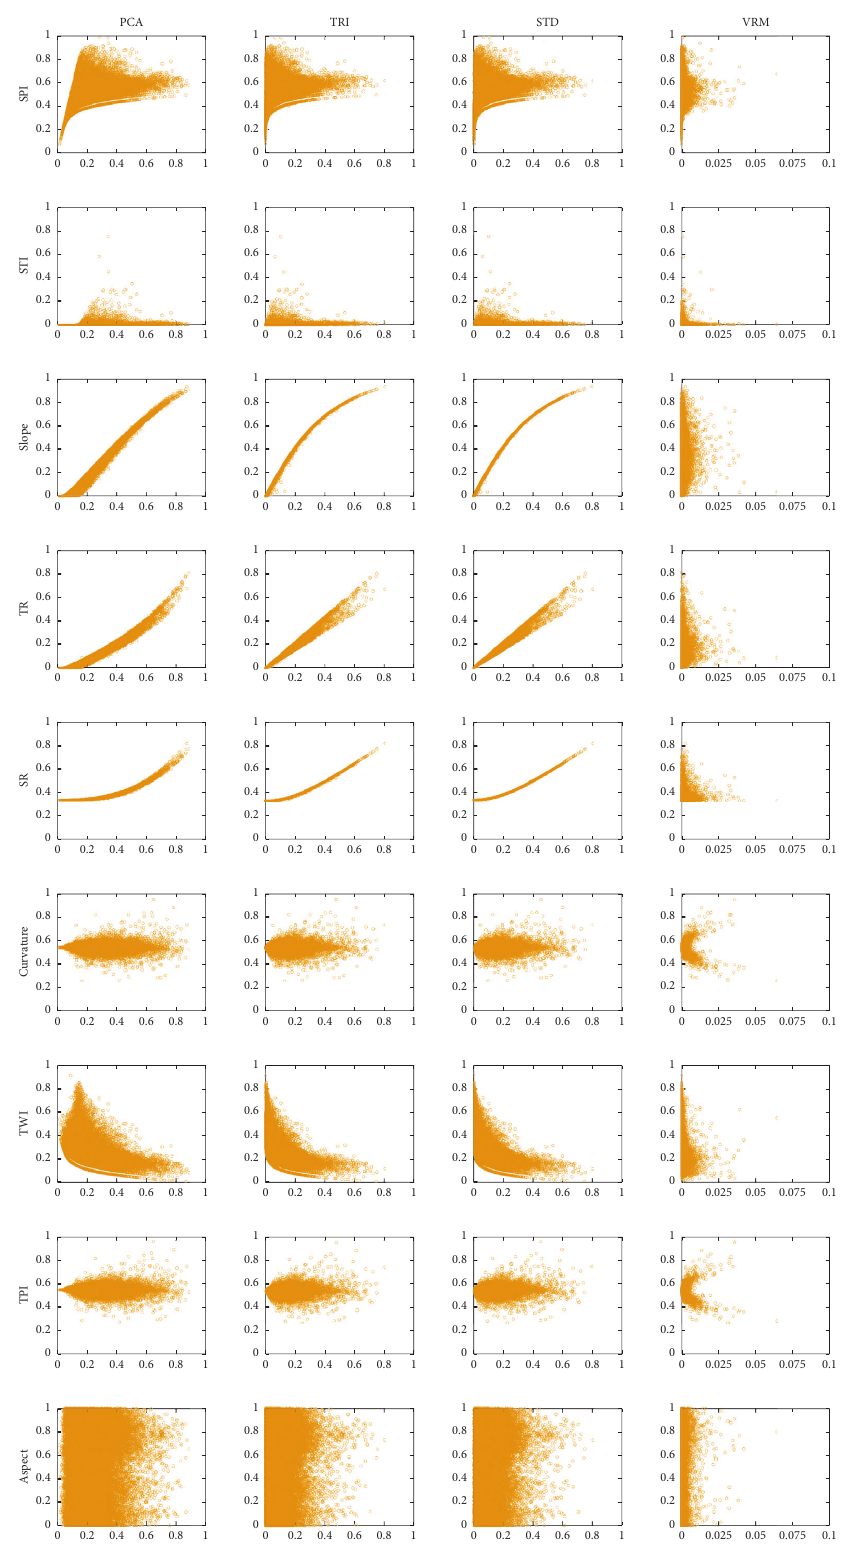
Figure 14: Plots of the correlation between the models and tested